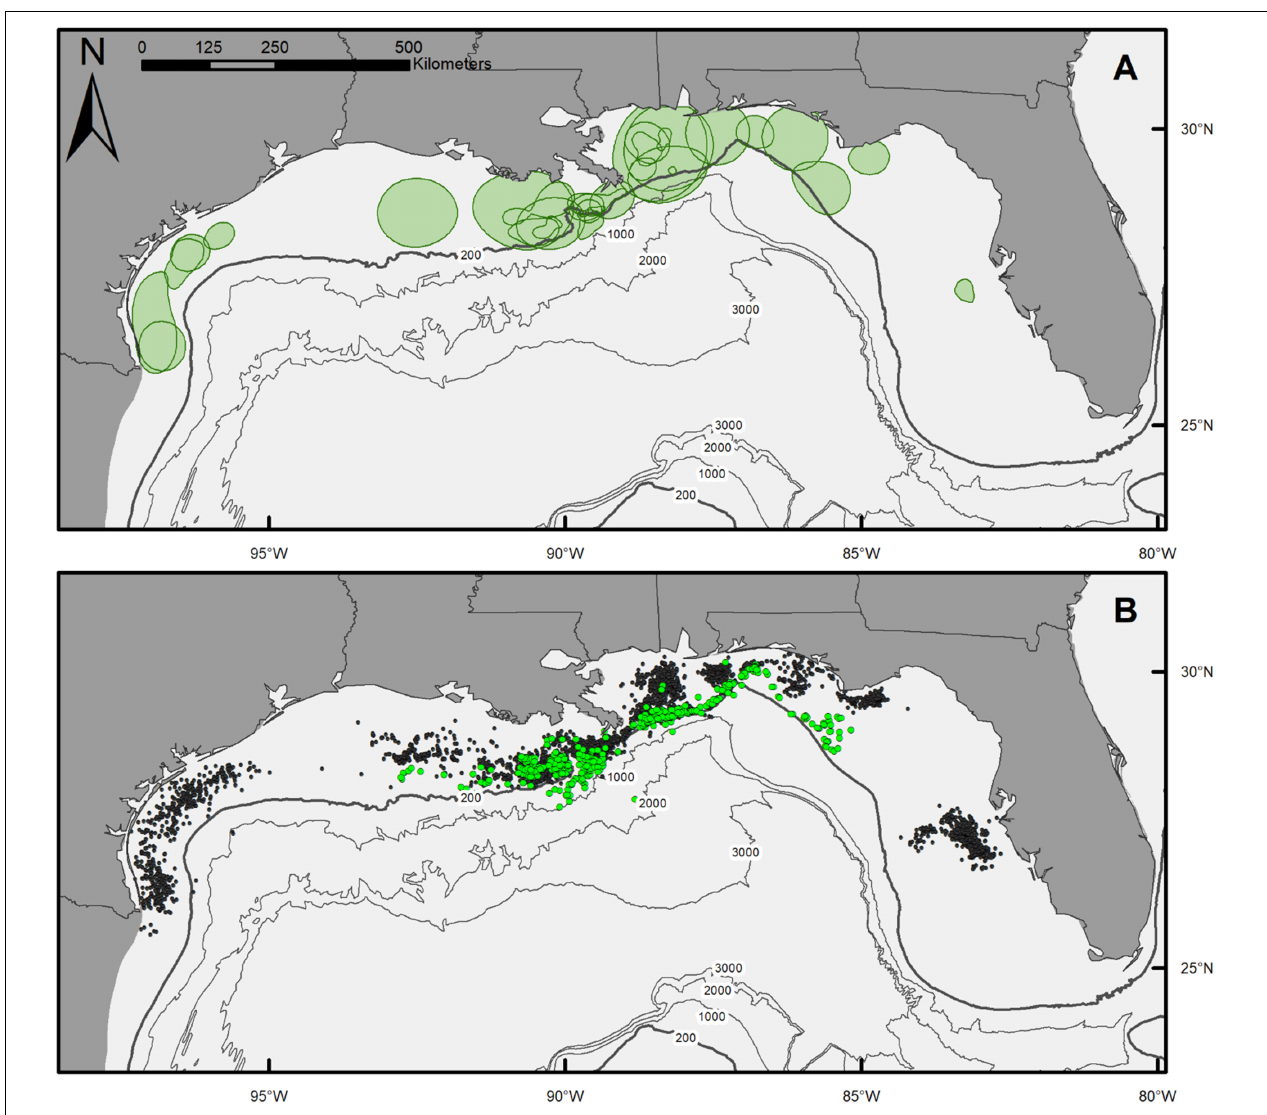
FIGURE 1 | (A) Map of 50% kernel density estimates (KDE) for individual scalloped hammerheads across the northern Gulf of Mexico. (B) Map of SPOT tag detections of male (black circles) and female (green circles) scalloped